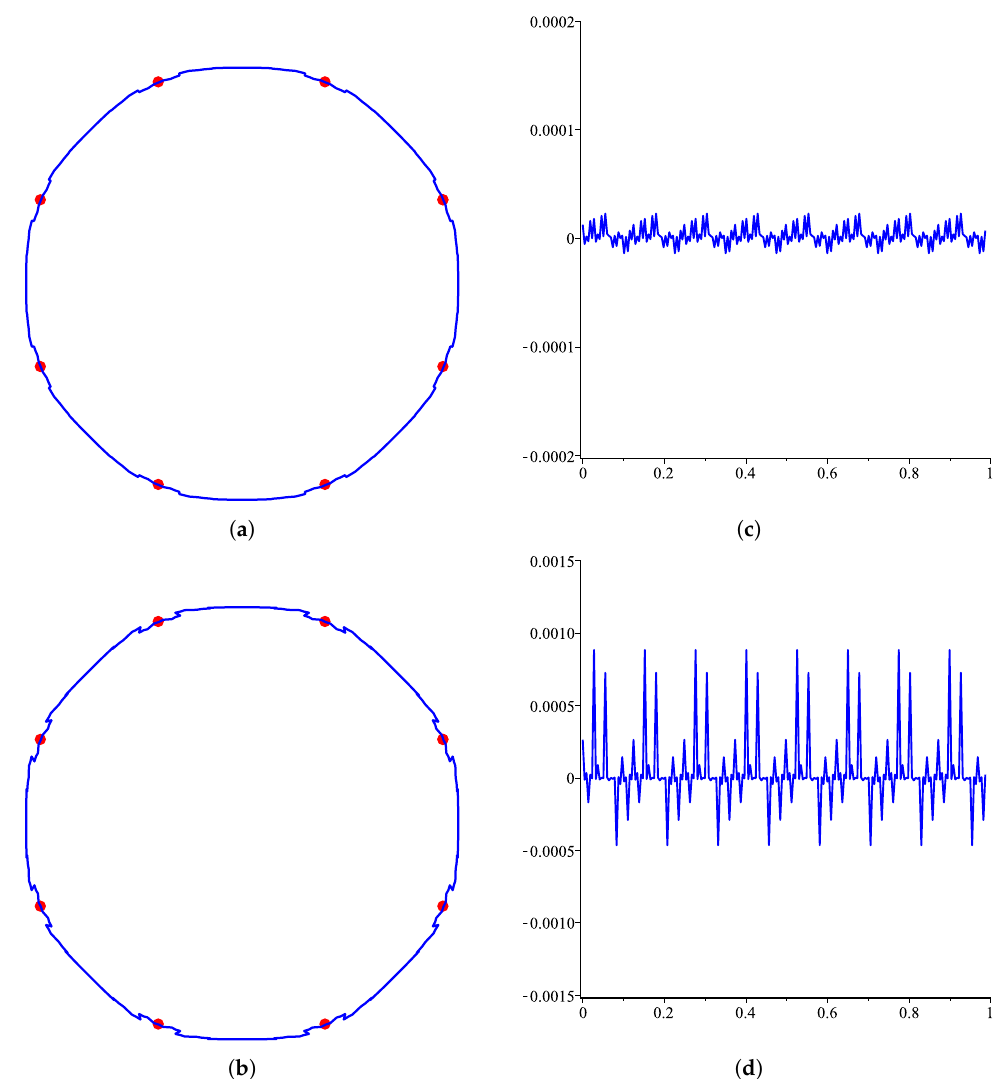
Figure 2. Results for various choices of the parameter u are shown on the left together with their corresponding curvature on the right. From top to bottom: u = 0.0076 and 0.0077. ( a ) Limit curve at u = 0.0076; ( b ) Limit curve at u = 0.0077; ( c ) Curvature plot of ( a ); ( d ) Curvature plot of ( b